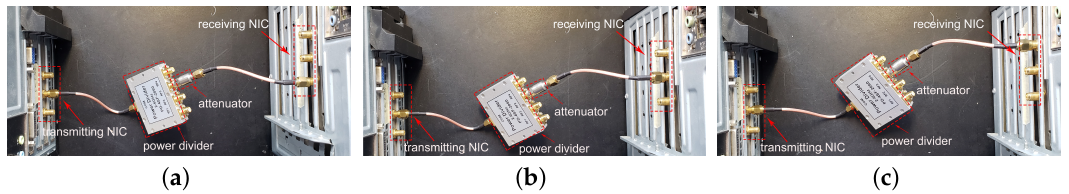
Figure 4. The connection of the antenna port of the transmitting NICand the receiving